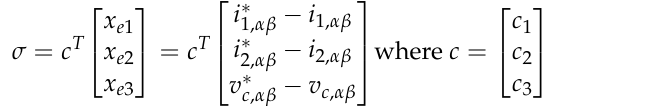
Figure 5. LCL filter single line diagram.